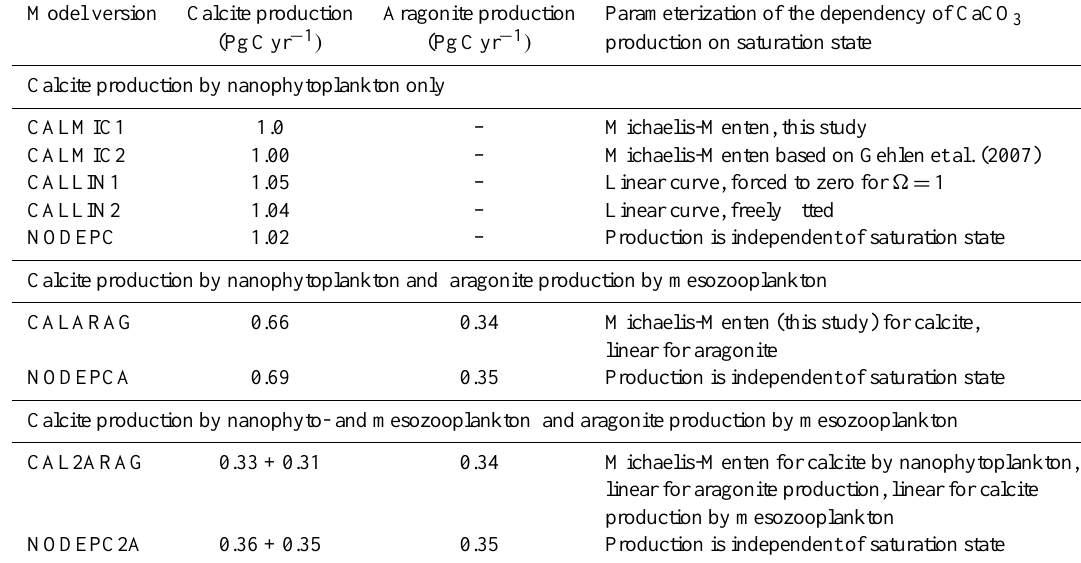
Table 1. Simulated pre-industrial CaCO 3 production (after 3000yr of integration) for different parameterizations of CaCO 3 production in the Bern3D/PISCES model.